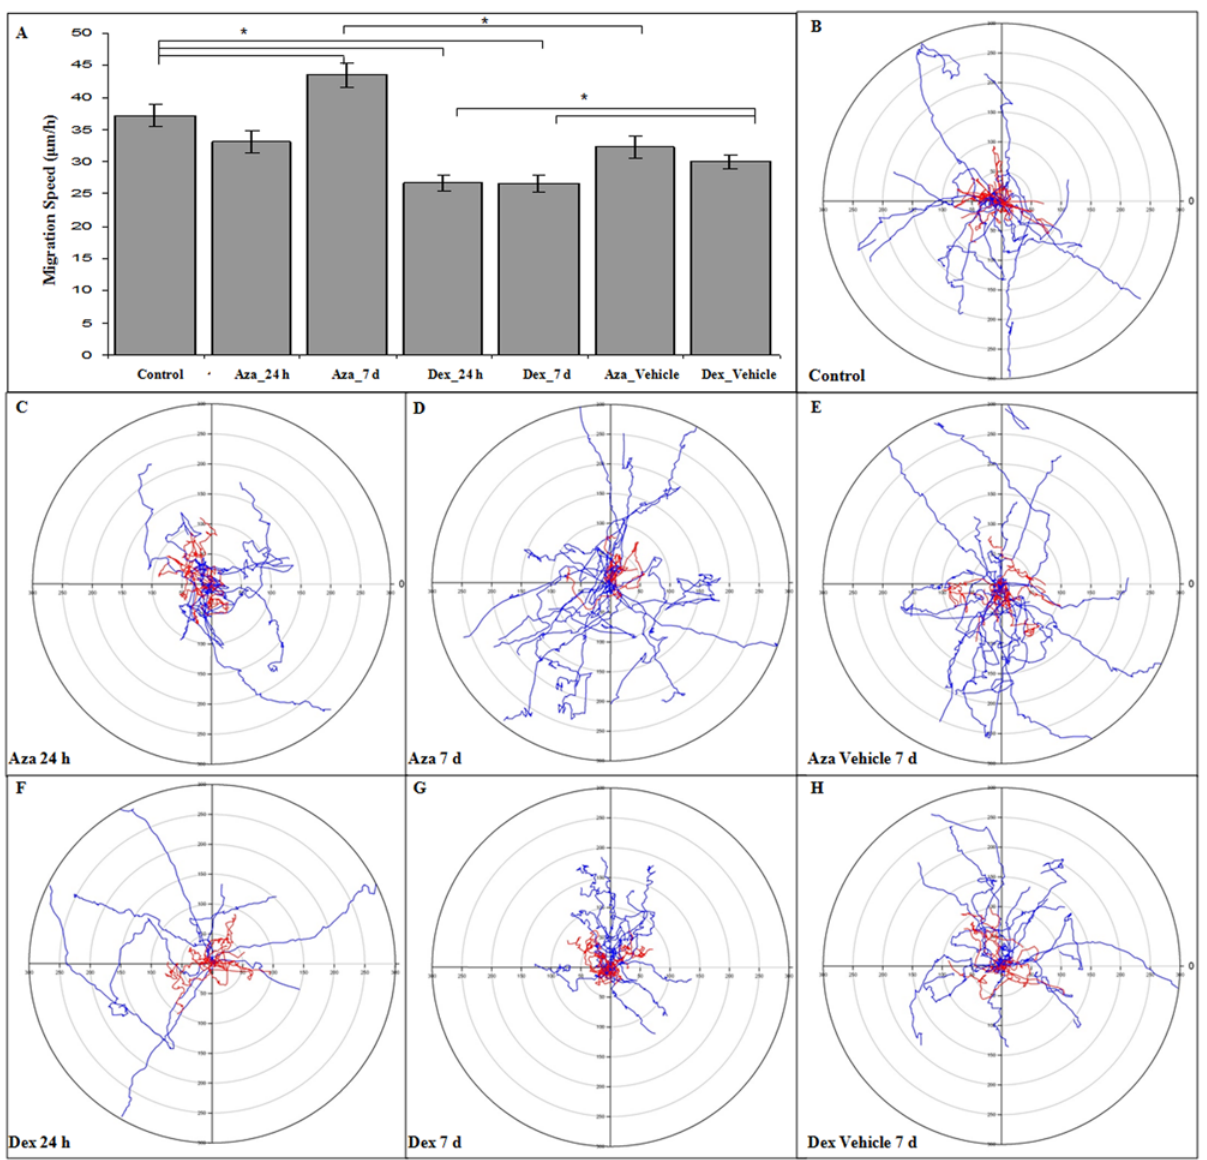
Fig 7. MSC migration speed and spatial trajectory. MSCs were cultured for 24 h or 7 d with or without AZA 1 μ M or DEX 10 μ M, plated on fibronectin 2 μ g/mL and imaged using time-lapse analysis. (A) DEX treatment induced a decrease in migration speed, while AZA was associated with a faster motility property. The ST of each migratory cell was accessed through the use of X and Y values, which were normalized to start at a virtual migratory starting point (X = 0 and Y = 0) (B-H) . Individual lines on polar plots represent the ST of each cell, while red lines represent cells that stayed close to the starting point and blue lines represent cells that were more exploratory. DEX-treated cells were associated with a lower ST, while AZA showed a tendency to induce a more exploratory phenotype. * P < 0.05, n = 4. MSC migration speed was analyzed through ANOVA post-hoc Tukey HSD, and comparisons were made between all groups; the differences among the main groups are represented in the